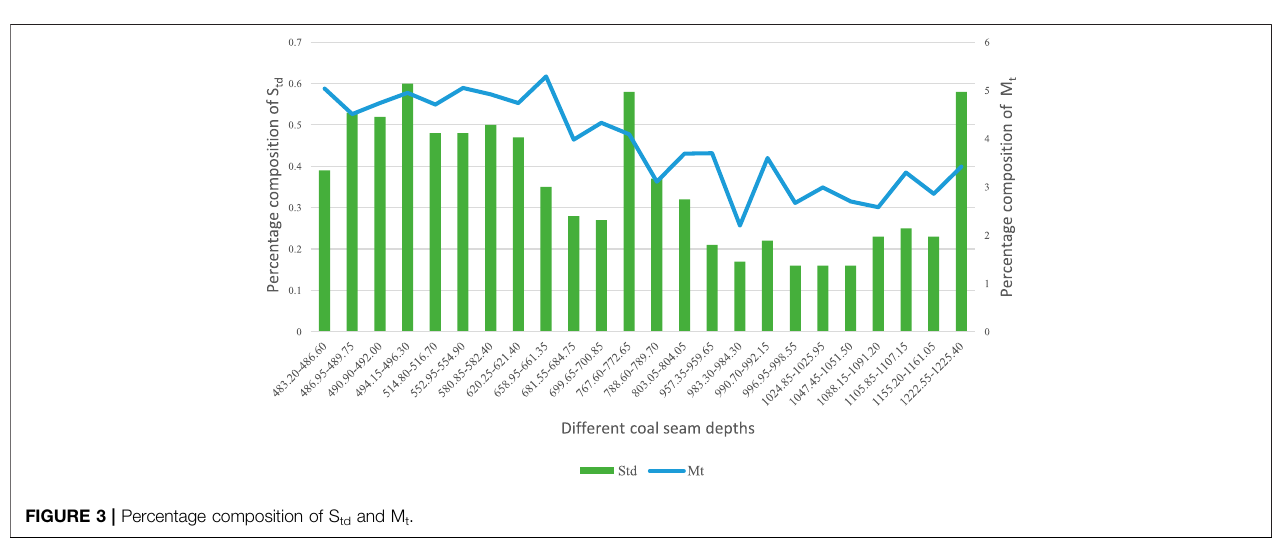
FIGURE 3 | Percentage composition of S td and M t